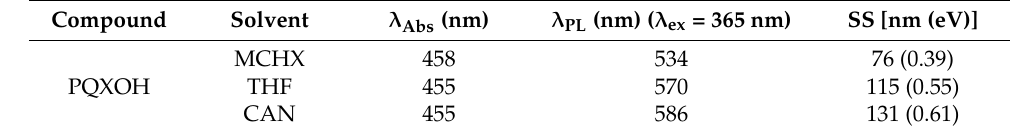
Table 2. Position of the absorption and emission of the tested PQXOH in various solvents.